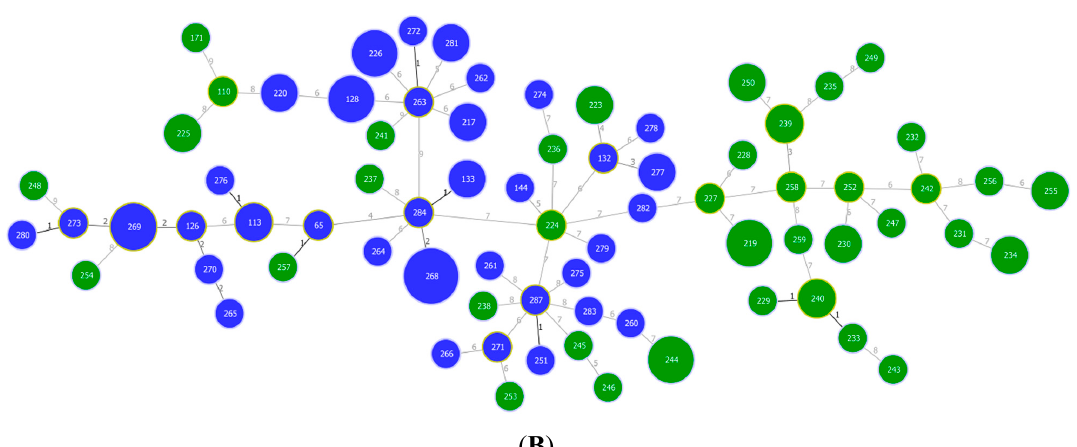
Figure 2. Population structure of V. vulnificus biotype 1 isolates from the North Sea and Baltic Sea obtained by goeBURST analysis based on MLST allelic profiles. Each sequence type (ST) is displayed as a circle with a size proportional to the number of isolates by which it is represented. The different colors indicate the geographical origin: North Sea (green) and Baltic Sea (blue). Single locus variants (SLVs) are connected via black lines. Light green halos around the circles indicate the respective founder of the group. ( A ) Population snapshot based on MLST allelic profiles. Clonal complexes (CC1–CC7) formed at the SLV level are highlighted by black edging; ( B ) Full Minimum Spanning Tree based on MLST allelic profiles. The number of different alleles between two STs is shown next to the connection lines.